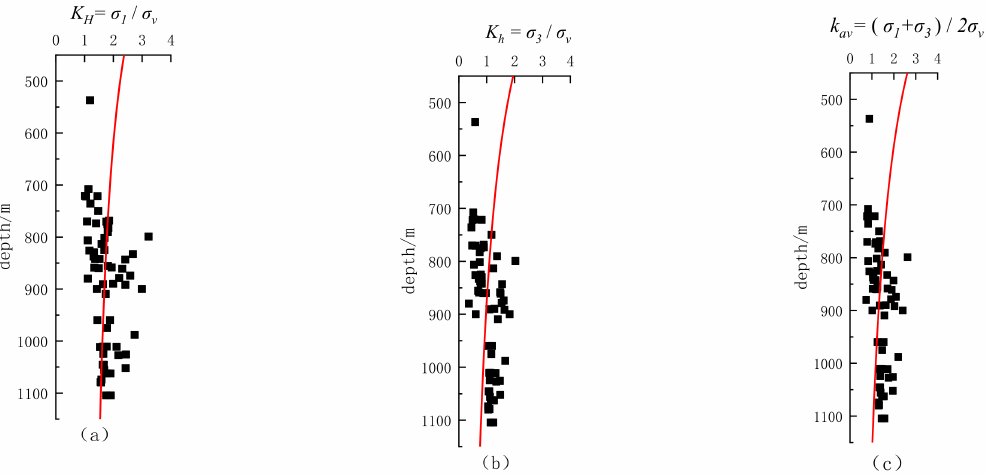
Figure 5. Fitting curves of the lateral pressure coefficients changing with the depth. ( a ). Ratio of horizontal stress to vertical stress; ( b ) Ratio of minimum principal stress to vertical stress; ( c ) Ratio of average horizontal stress to vertical